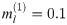
Effects of chirality persist despite growth rate differences.We competed strains with different growth rates and chirality starting from well-mixed initial conditions. The abundances of the strains were equal at the beginning of the simulations, but changed over time leading either to stable coexistence or to the exclusion of one of the strains. The outcome of the competition depends on the relative growth rates of the strains quantified by Δg. The competition between a left-handed strain and a faster growing non-chiral strain is shown in (A). The non-chiral strain is outcompeted even if it has a growth advantage as high as to 2%. The chiral strain becomes extinct only when its growth penalty exceeds 7%. For intermediate Δg, the two strains stably coexist. Similar dynamics occur during the competition between the strains with equal, but opposite chirality shown in panel (B). The stable coexistence between the strains is destroyed only by growth rate differences higher than about 7%. Here, m0 = ms = mb = md = 0 for both strains and N = 200. In (A), ml(1)=0.1, mr(1)=0.0, ml(2)=0.05, mr(2)=0.05 on a lattice of 1000x3600 sites. We fixed g = 0.01 for the left handed-strain and varied the growth rate of the non-chiral strain according to g(1 + Δg/100%). In (B), ml(1)=0.09, mr(1)=0.01, ml(2)=0.01, mr(2)=0.09 on a lattice of 500x3000 sites. We set g = 0.1 for the left-handed strain, and varied the growth rate of the right-handed strain according to g(1 + Δg/100%). The distances on the x-axis were measured in 100 units where Δx = Δy = 1 unit. We verified stable coexistence by starting the simulation above and below the observed steady-state relative abundances and checking that they return to the same steady-state values.